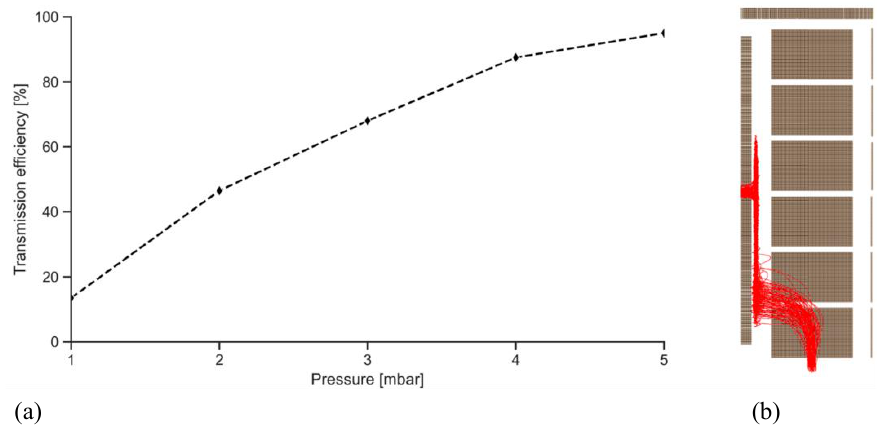
Fig. 4 . (a) Simulated ion transmission in the mbar range (b) Example of ion motion under applied DC and RF potentials at 5